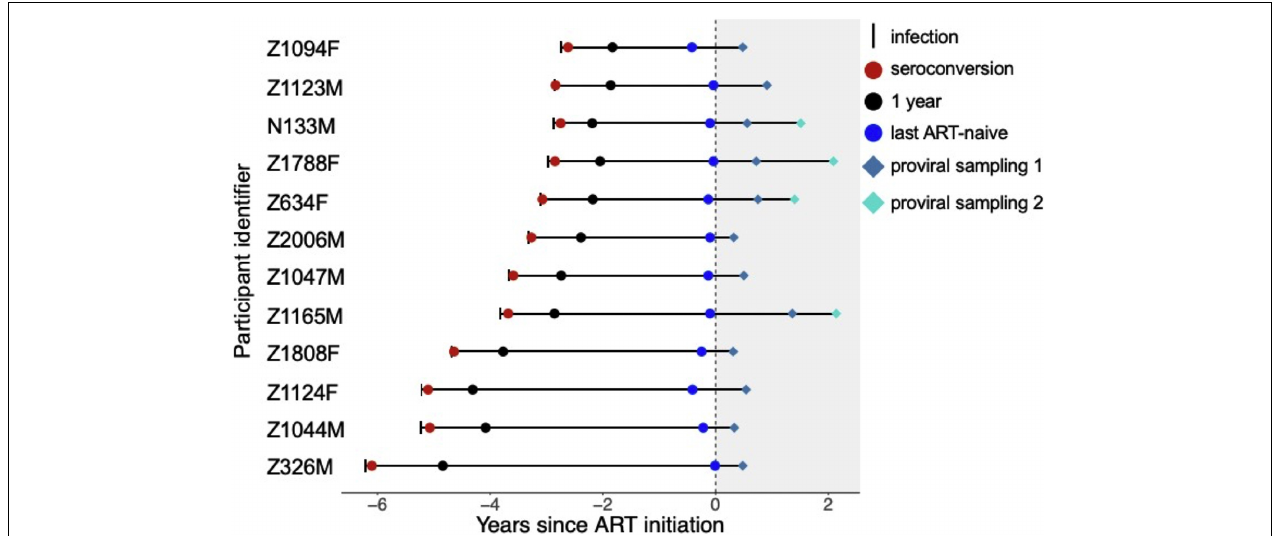
FIGURE 1 | Participant sampling timeline. Infection and sampling timelines for the 12 study participants, sorted by their untreated infection duration, and using ART initiation as the reference time-point. IDs ending in “M” and “F” denote male and female participants, respectively. The short vertical line denotes the estimated date of infection, and the gray shaded area denotes ART. The three colored circles denote the dates when plasma HIV RNA env sequences were sampled: at seroconversion (red circle), 1 year after infection (black circle) and before ART (blue circle). The colored diamonds denote when proviral sequences were sampled on ART. Figure adapted from Brooks et al.